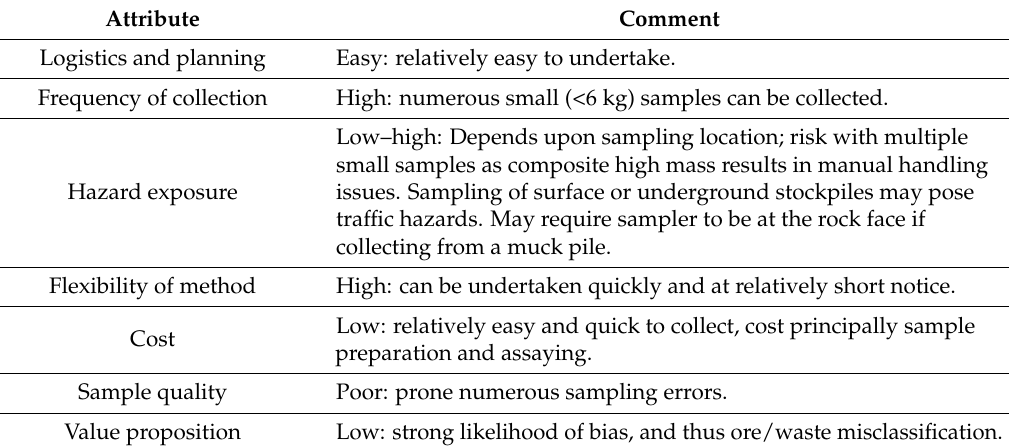
Table 18. Grab sampling